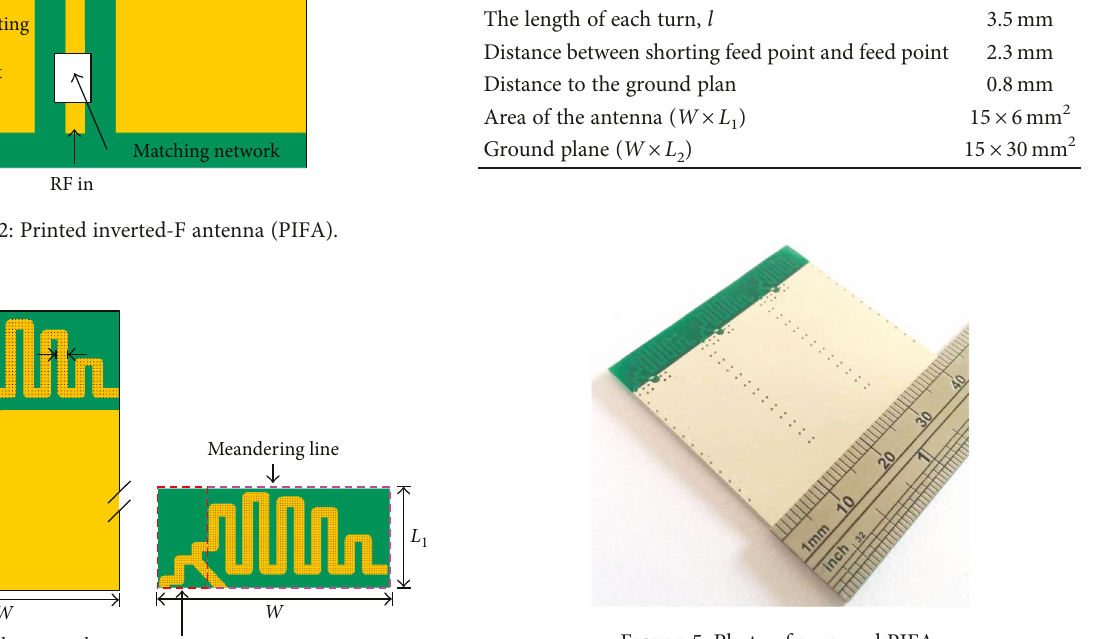
Figure 5: Photo of proposed PIFA.